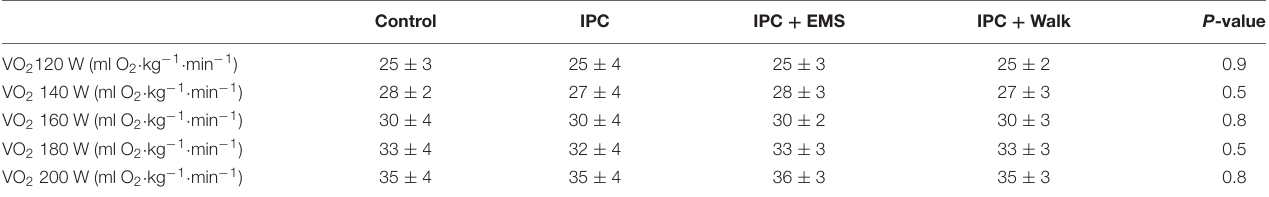
TABLE 1 | Oxygen consumption at submaximal exercise intensities during an incremental cycling test after no intervention (Control) ischemic preconditioning (IPC), ischemic preconditioning combined with electrical muscle stimulation (IPC + EMS), and ischemic preconditioning performed during slow walking at 2 mph (IPC + Walk). Control